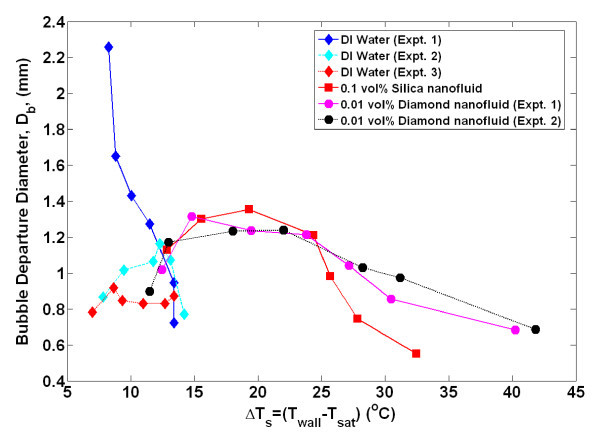
Average bubble departure diameter as measured by infrared thermometry. Uncertainty in departure diameter is ± 2%.